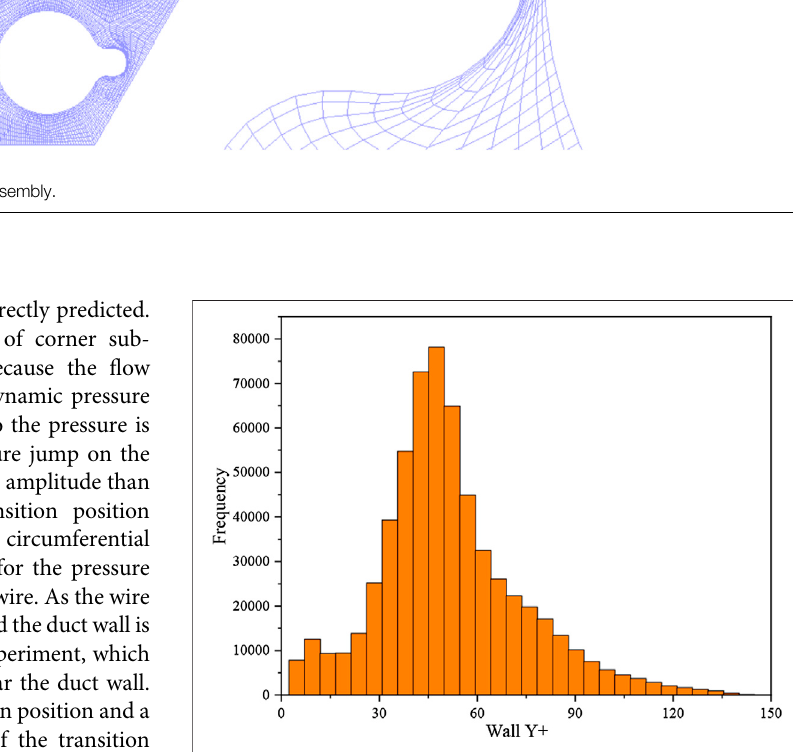
FIGURE 7 | Number of cells with wall y +